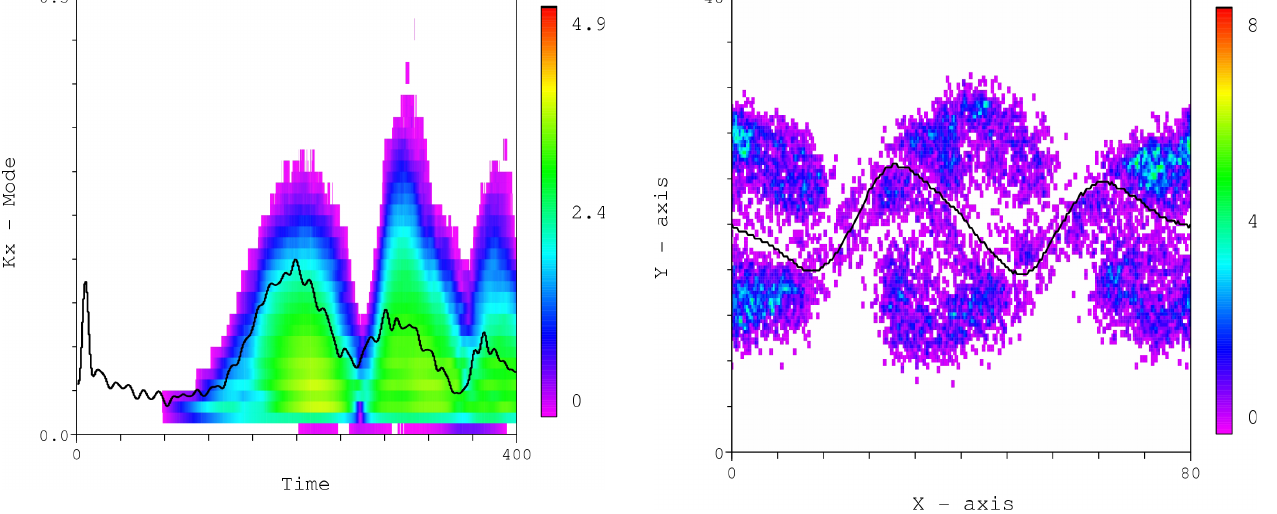
Fig. 6. Color-coded number of particles crossing once the disconti-